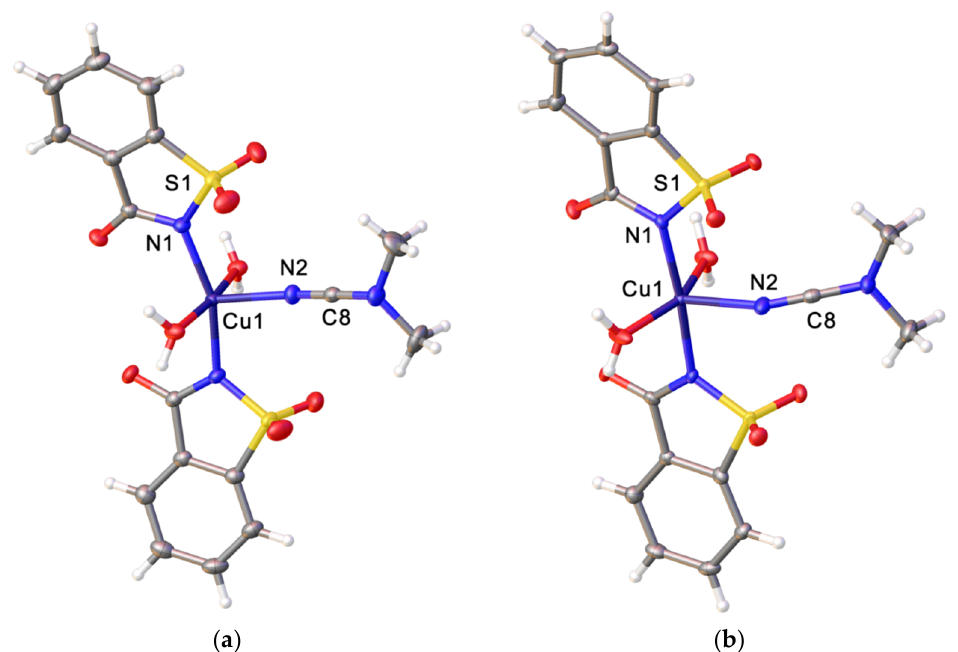
Figure 1. ( a ) Molecular structure of 1 with the atomic numbering. Thermal ellipsoids are given at the 50% probability level. ( b ) Molecular structure of 1 ·2H 2 O with the atomic numbering. Thermal ellipsoids are given at the 50% probability level. The H 2 O of hydration was omitted for clarity.